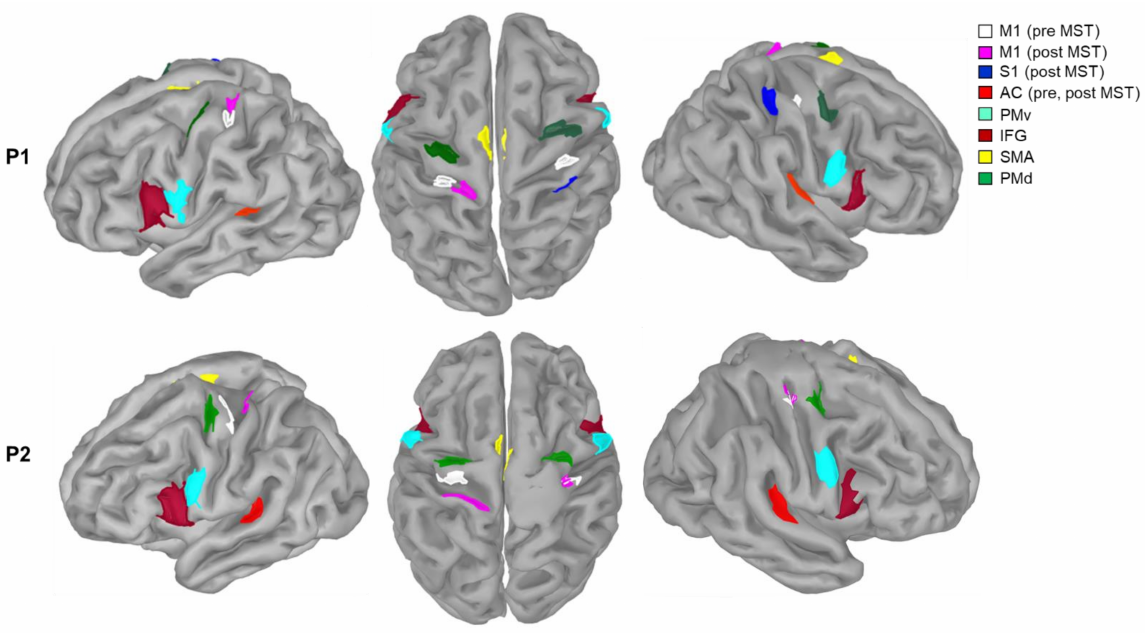
Figure 2. Regions of interests of the auditory-motor network created by Brainstorm. M1 and AC ROIs were defined from individual functional data pre- and post-MST; SMA, PMd, and PMv were selected from a previously published study [58];